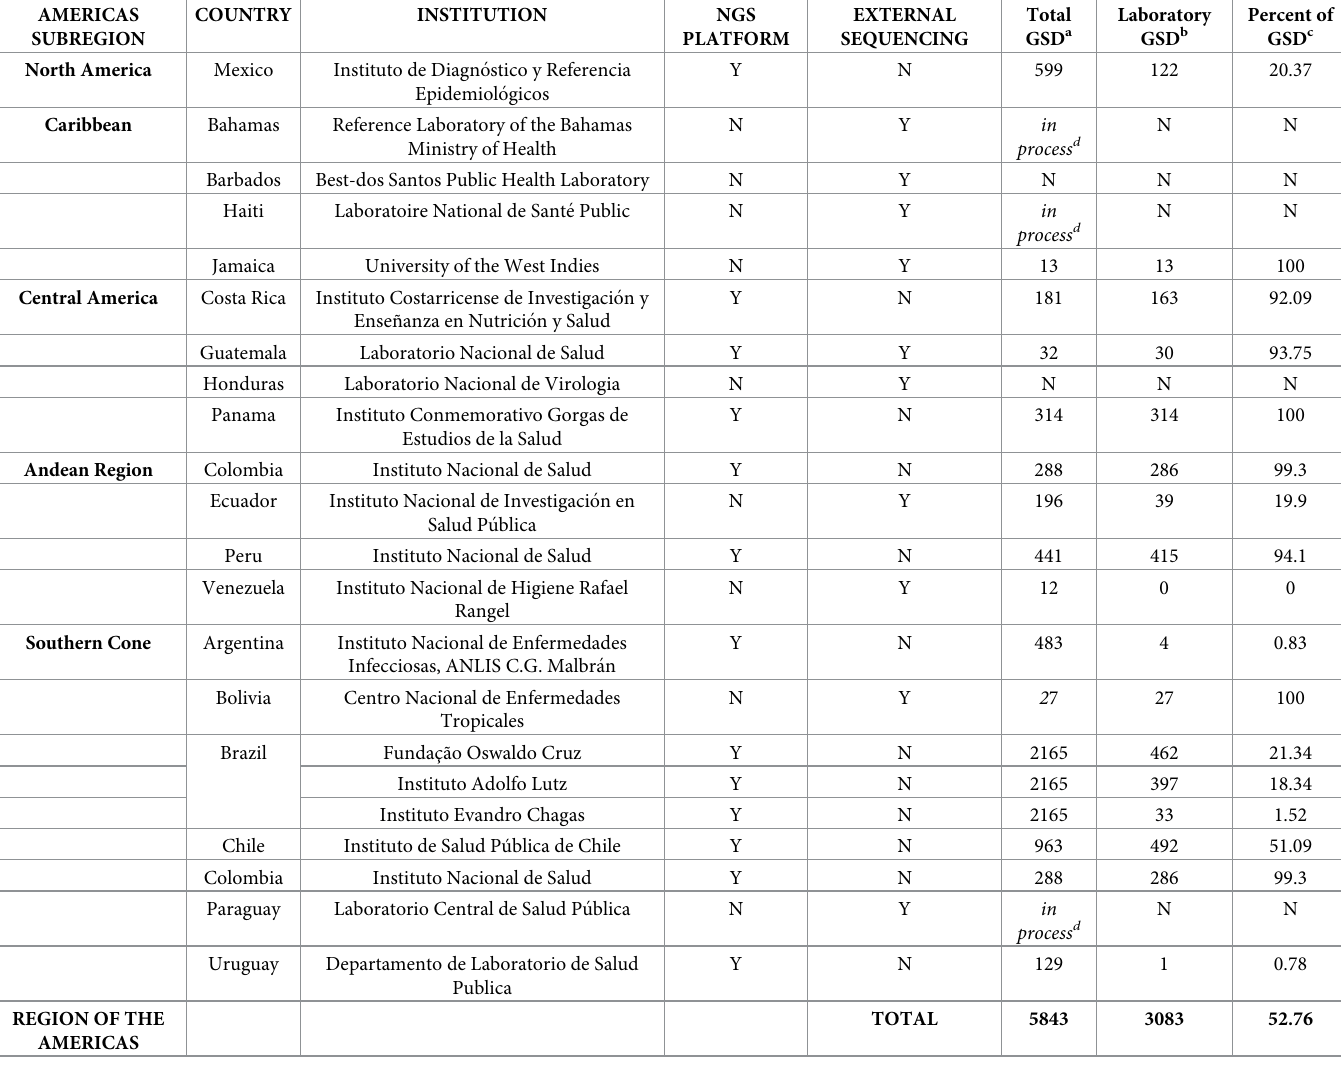
Table 1. Laboratories participating in the COVID-19 Genomic Surveillance Regional Network in the Americas, July 2020. AMERICAS